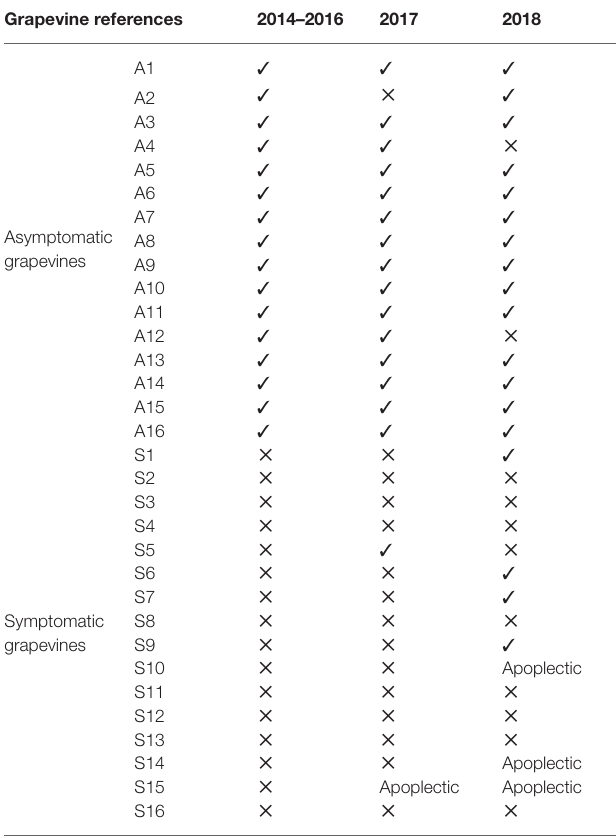
TABLE 2 | Notation table presenting the status of the 16-year-old Cabernet- Sauvignon cultivar ( Vitis vinifera L.) that underwent a 2-year physiological monitoring in 2017 and